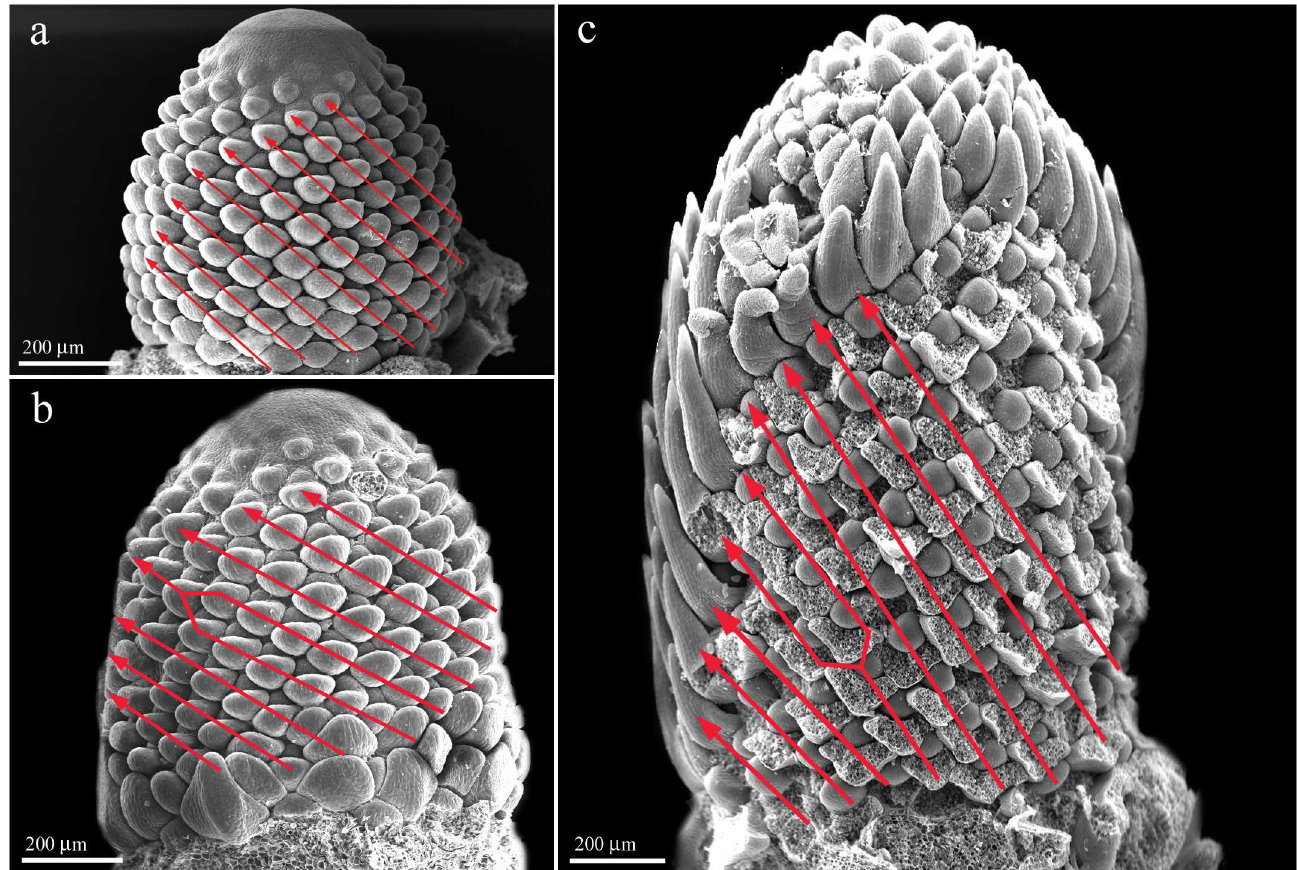
Fig 4. Parastichy formation in Dipsacus fullonum . (a) Regularpattern. (b) Parastichiesunite at the tip of the meristem. (c) Additionalcontact lines appearafter meristem expansion.